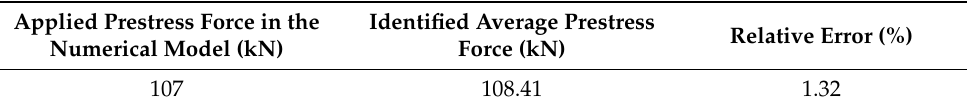
Table 12. Comparison of the applied and identified average prestress forces from strain measurements during the free vibration period of the dynamic